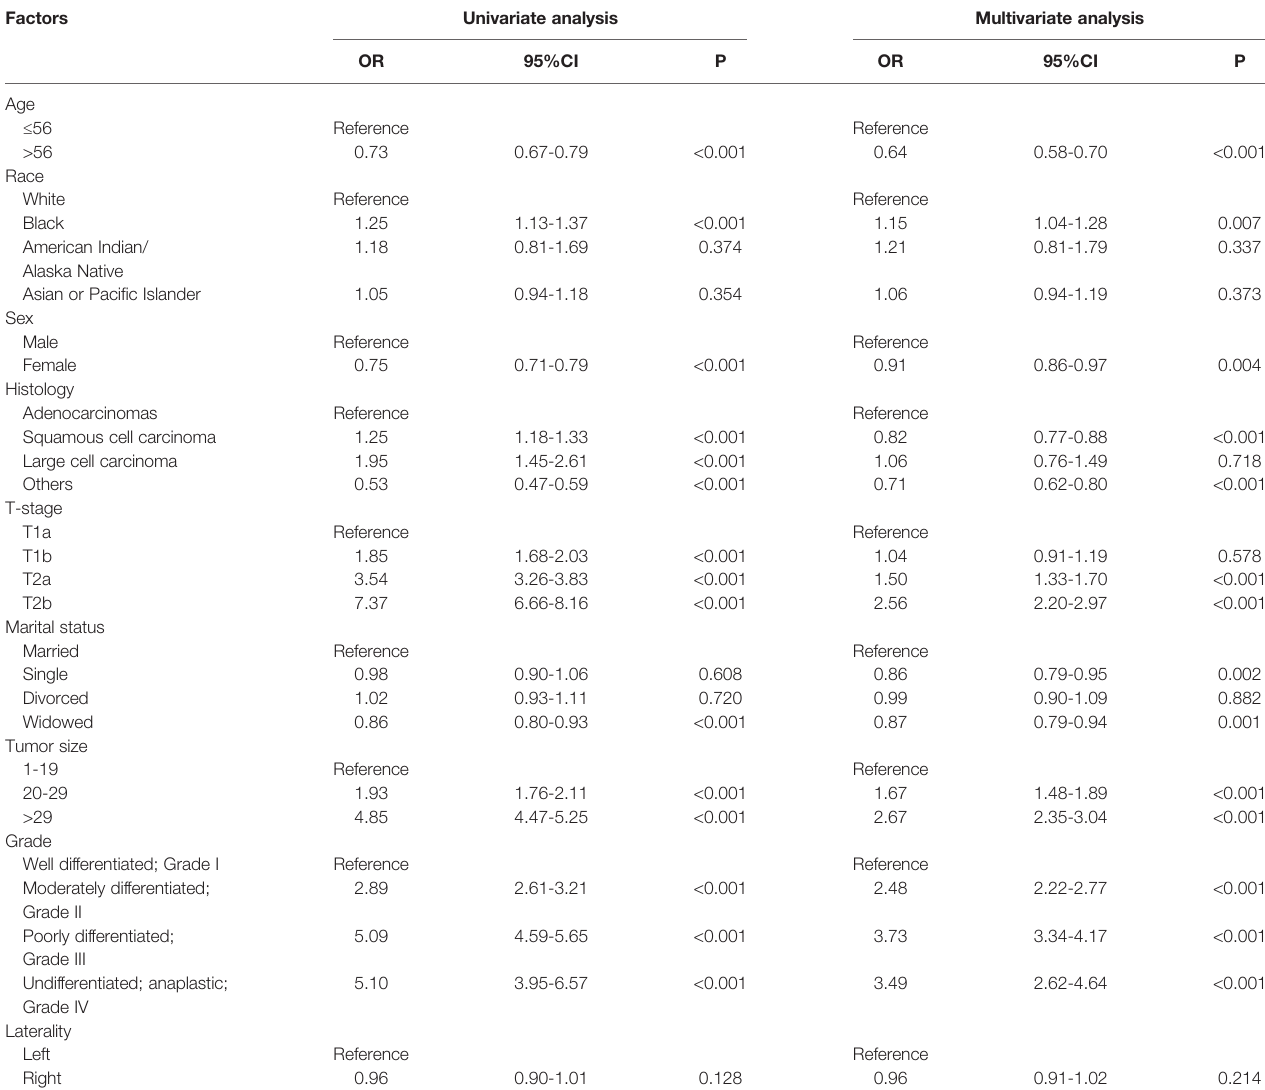
TABLE 3 | Logistic regression analysis of the risk factors for lymph node metastasis in cohort